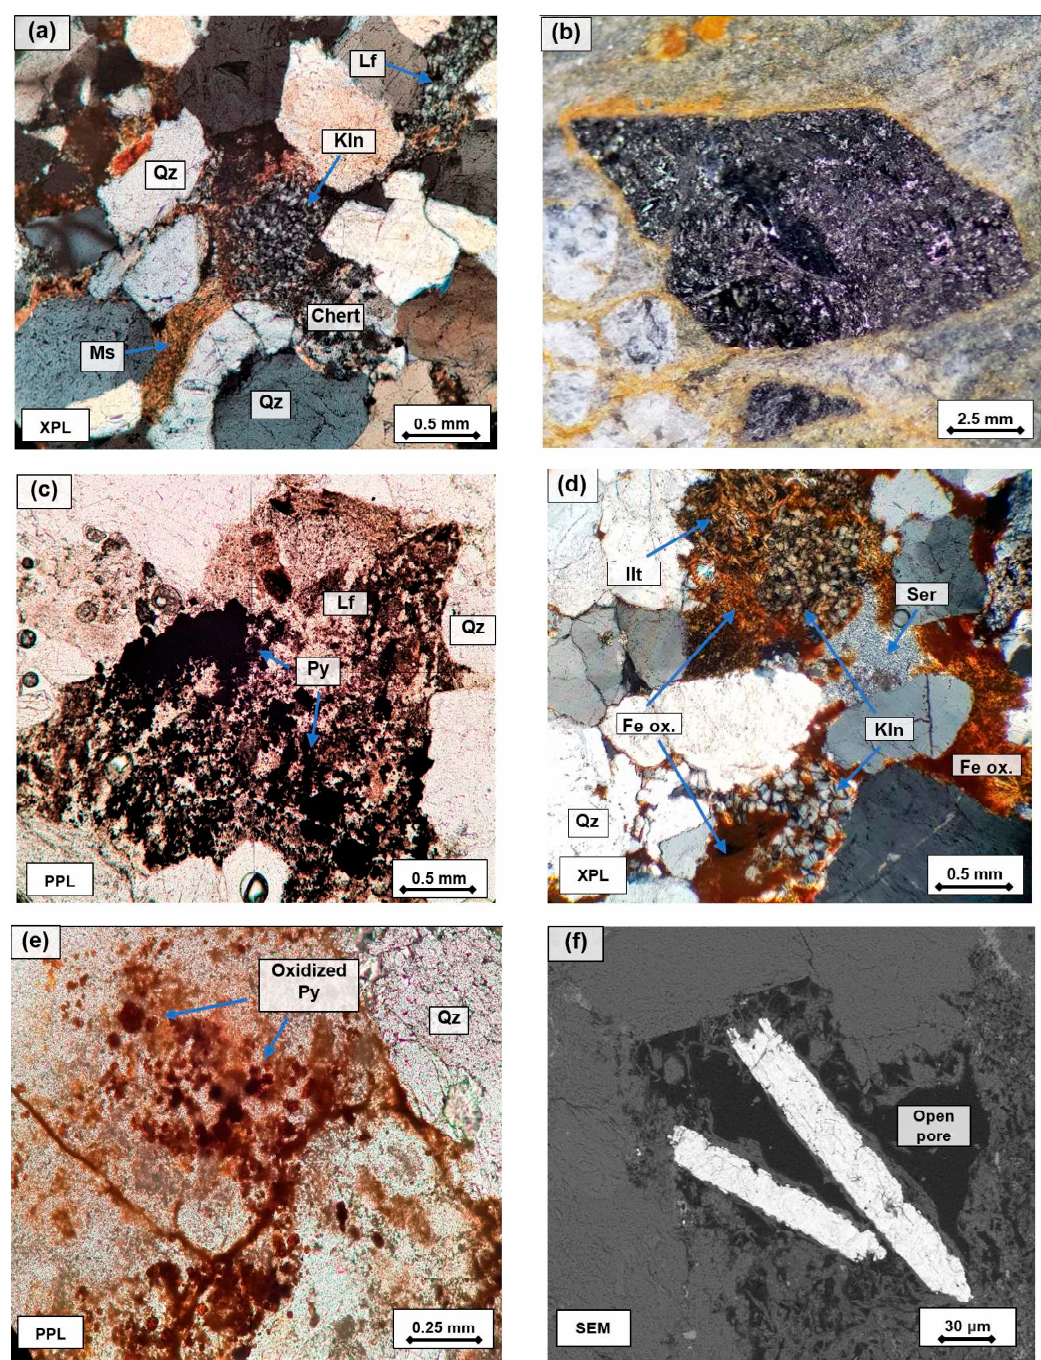
Figure 5. Photomicrographs of the main components found in the rock sequence. ( a ) Plastic lithic fragments, muscovite flakes and booklet crystals of kaolinite ‐ group minerals squeezed among quartz and chert grains. The authigenic origin of the kaolinite ‐ group minerals is interpreted from the pseudo ‐ hexagonal form of the pore space. ( b ) Oxidation of a coal lithic fragment within conglomeratic sandstone interval. ( c ) Unaltered cluster of microcrystalline pyrite associated with a sedimentary lithic fragment. ( d ) Weathered thin section with iron (oxide ‐ ) hydroxides precipitating around and on the matrix and rock components. ( e ) Weathered cluster of microcrystalline pyrite completely transformed to iron (oxide ‐ ) hydroxide (holo ‐ pseudomorph). ( f ) SEM image of prismatic barite crystals in a pore space. Lf = lithic fragment, Ms = muscovite, Kln = kaolinite ‐ group minerals, Qz = quartz, Py = pyrite, Ilt = illite, Ser = sericite, Fe ox. = iron (oxide ‐ ) hydroxides, PPL = plane polarized light, XPL = cross polarized light, SEM = scanning electron microscope.